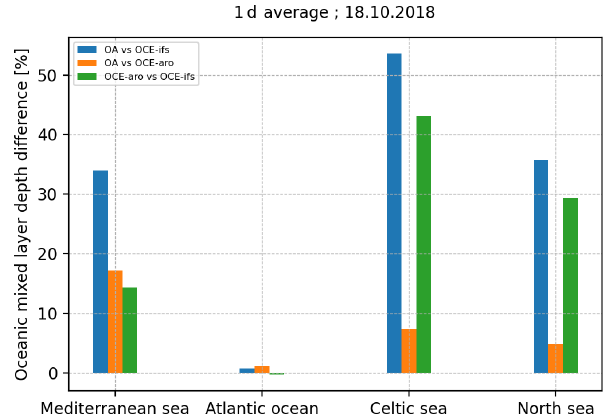
Figure 10. Instantaneous oceanic mixed layer depth differences be- tween pairs of simulations after 168 simulated hours extracted in the four areas presented in Fig.